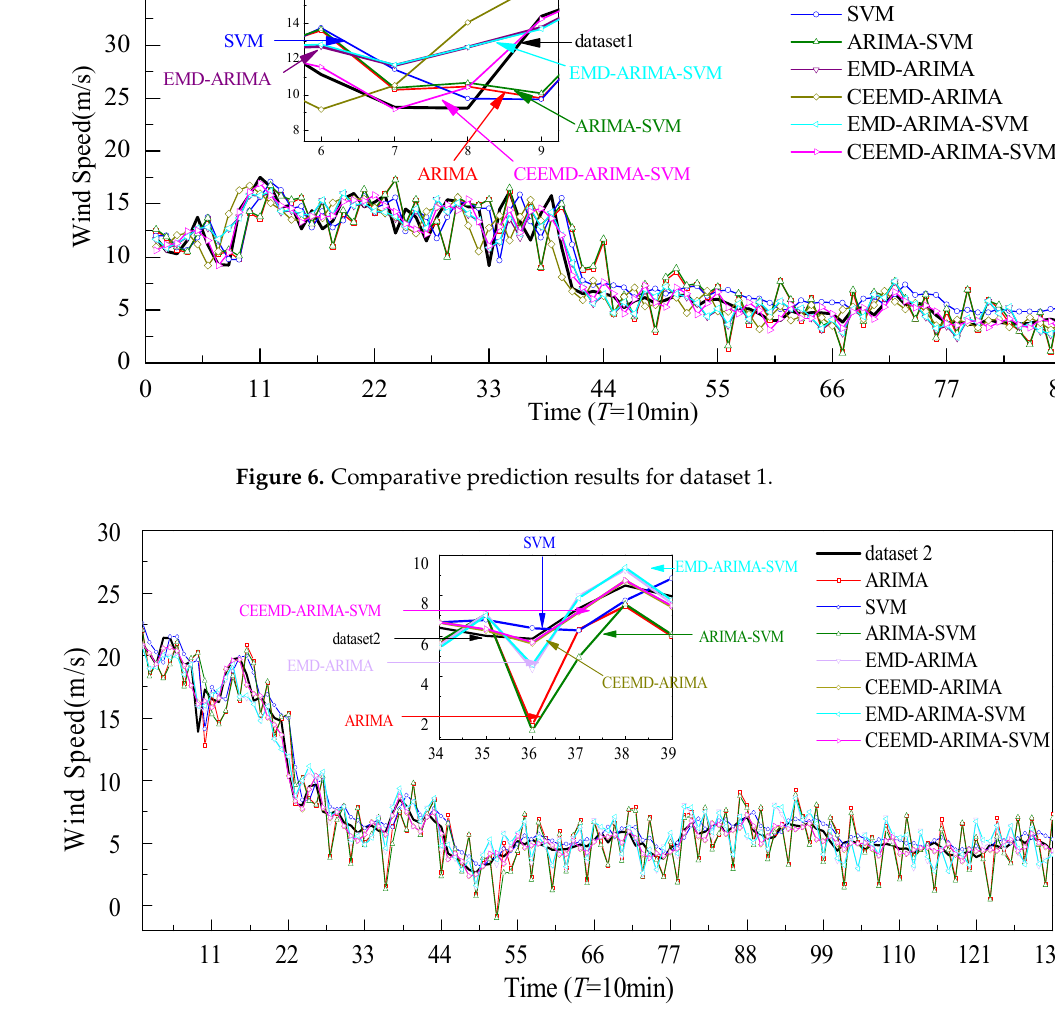
Figure 7. Comparative prediction results for dataset 2.